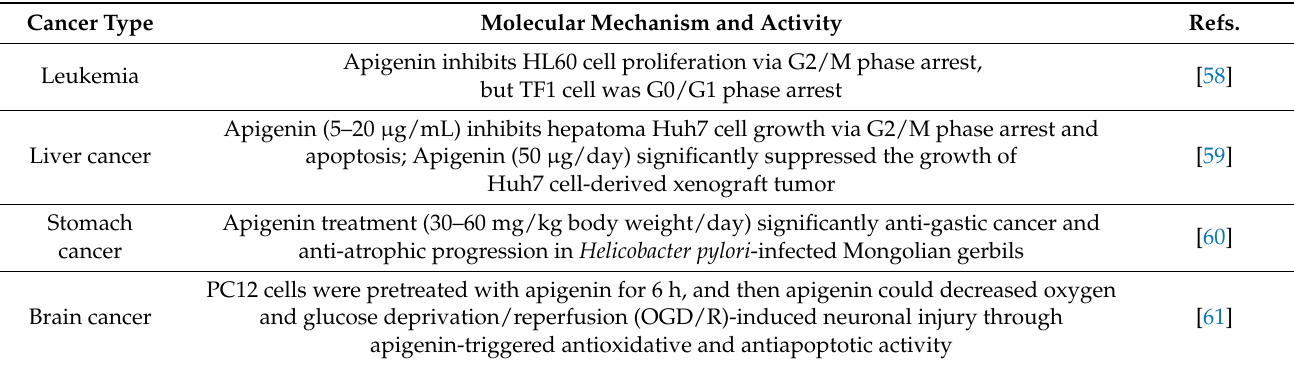
Table 1. Anticancer effects of apigenin on different human cancers.